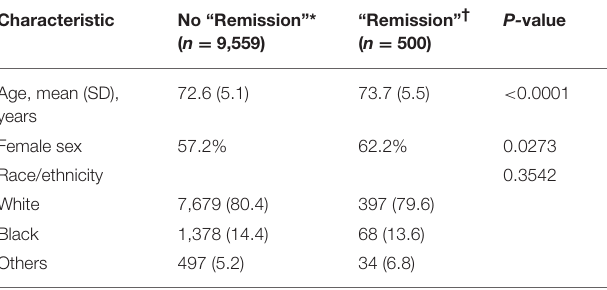
TABLE 1 | Baseline demographic and T2DM “remission”